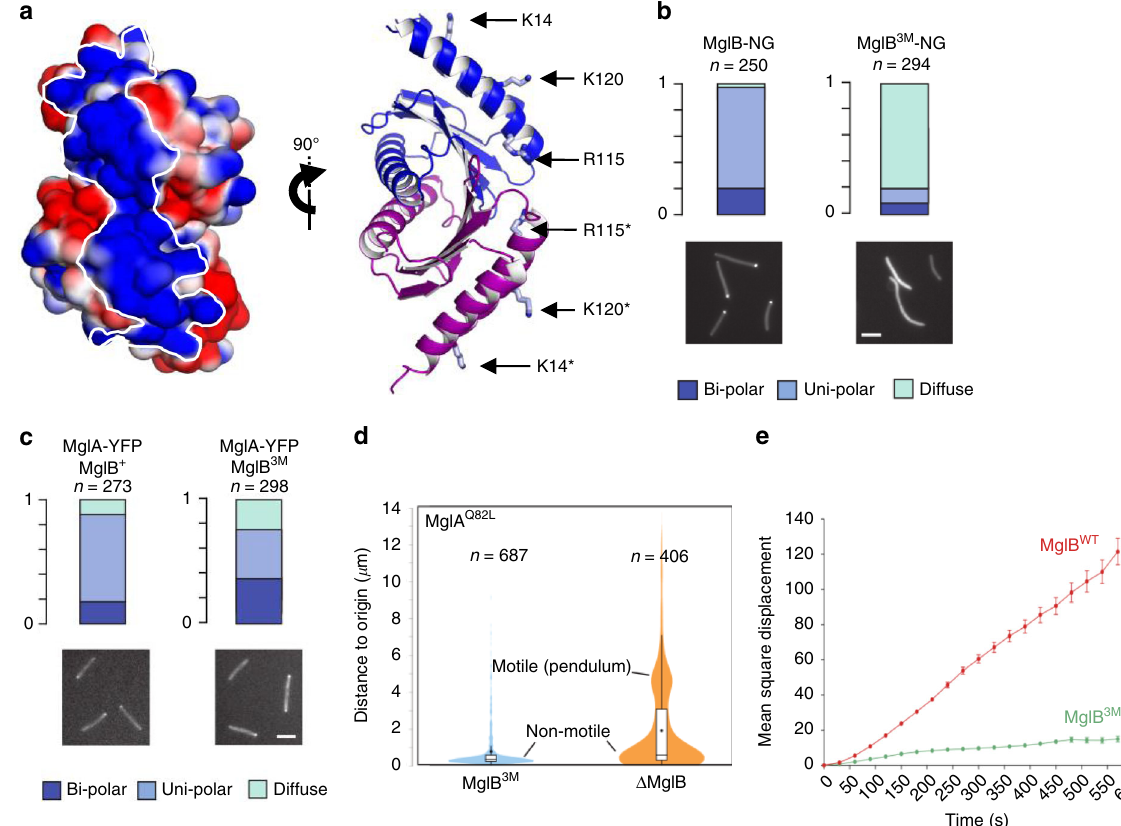
Fig. 4 The MglB positively charged tract determines the polar localization of MglB. a MglB features a positively charged tract opposite to the MglA-binding site. The left panel shows electrostatic potential calculated with APBS 50 . The tract is delineated by a white line. The right panel shows the residues in this tract mutated in MglA 3M . The two views are rotated by 90°. b MglB 3M -NG has a diffuse localization. Localizations of MglB-NG and MglB 3M -NG are shown. Scale bar = 2 µ m. c MglA-YFP retains polar localization in MglB 3M -expressing cells. Localization of MglA-YFP in cells expressing MglB or MglB 3M is shown. Scale bar = 2 µ m. d MglB 3M blocks the action of a GTP-locked MglA mutant. The motility of MglA Q82L -expressing cells was measured in mglB deletion or in mglB 3M -expressing strains. For each cell, motility is measured as the distance traveled from the origin for a time period of 45 min. Note that MglB 3M - expressing cells are mostly nonmotile while MglB WT -expressing cells show two distinct populations, one nonmotile and one motile with reduced traveled distance to origin due to previously described pendulum movements. e Expression of MglB 3M blocks motility. Motility is measured as the mean square displacement (MSD) of single cells on agar. The average MSD of n trajectories and associated standard error of the mean are shown for the wild-type strain ( n = 2658) and the MglB 3M strain ( n = 3616). MglB WT : DZ2 Δ mglB pSWU19-mglB WT , MglB 3M : DZ2 Δ mglB pSWU19-mglB 3M . Source data for panel ( e ) are provided as a Source Data